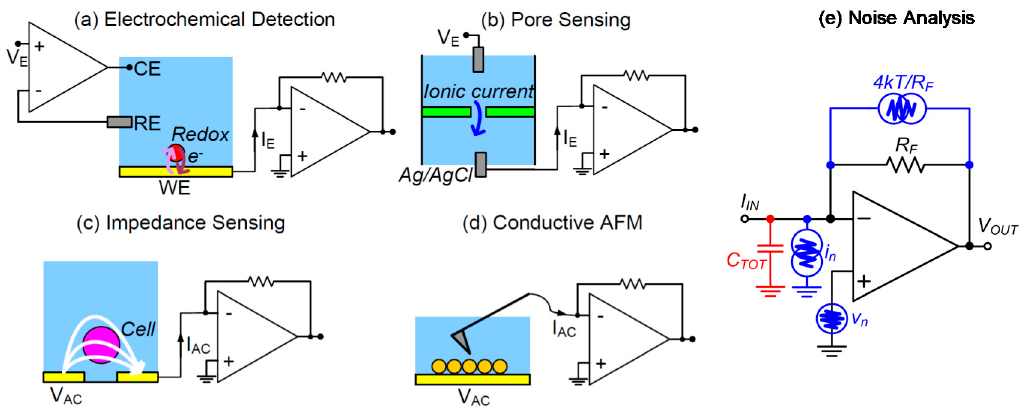
Figure 2. Examples of the application of a current front-end in bio-sensing for the: ( a ) redox detection of molecules, ( b ) current sensing molecule translocation through nanopores, ( c ) impedance detection, ( d ) nano-scale electrical probing, and ( e ) equivalent noise generators of the transimpedance amplifier (TIA).